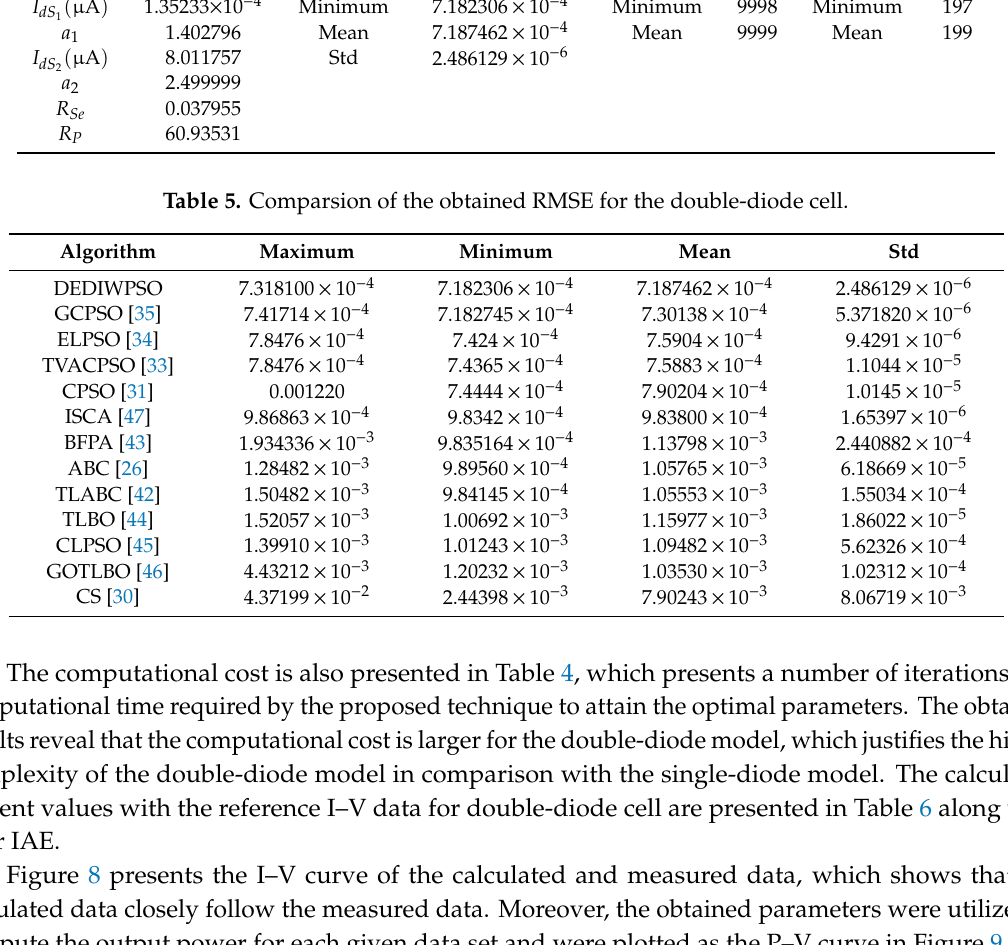
Voltage (V) Figure 9. P–V curve obtained from the calculated current for the double-diode cell. 0 Iterations Figure 10. Convergence curve for the double-diode cell. 4.2. Results for PV Module The experimental data for the Photo-watt PWP201 module were obtained from [24], which contain 26 pairs of I–V data. The selected module consists of 36 numbers of polycrystalline silicon